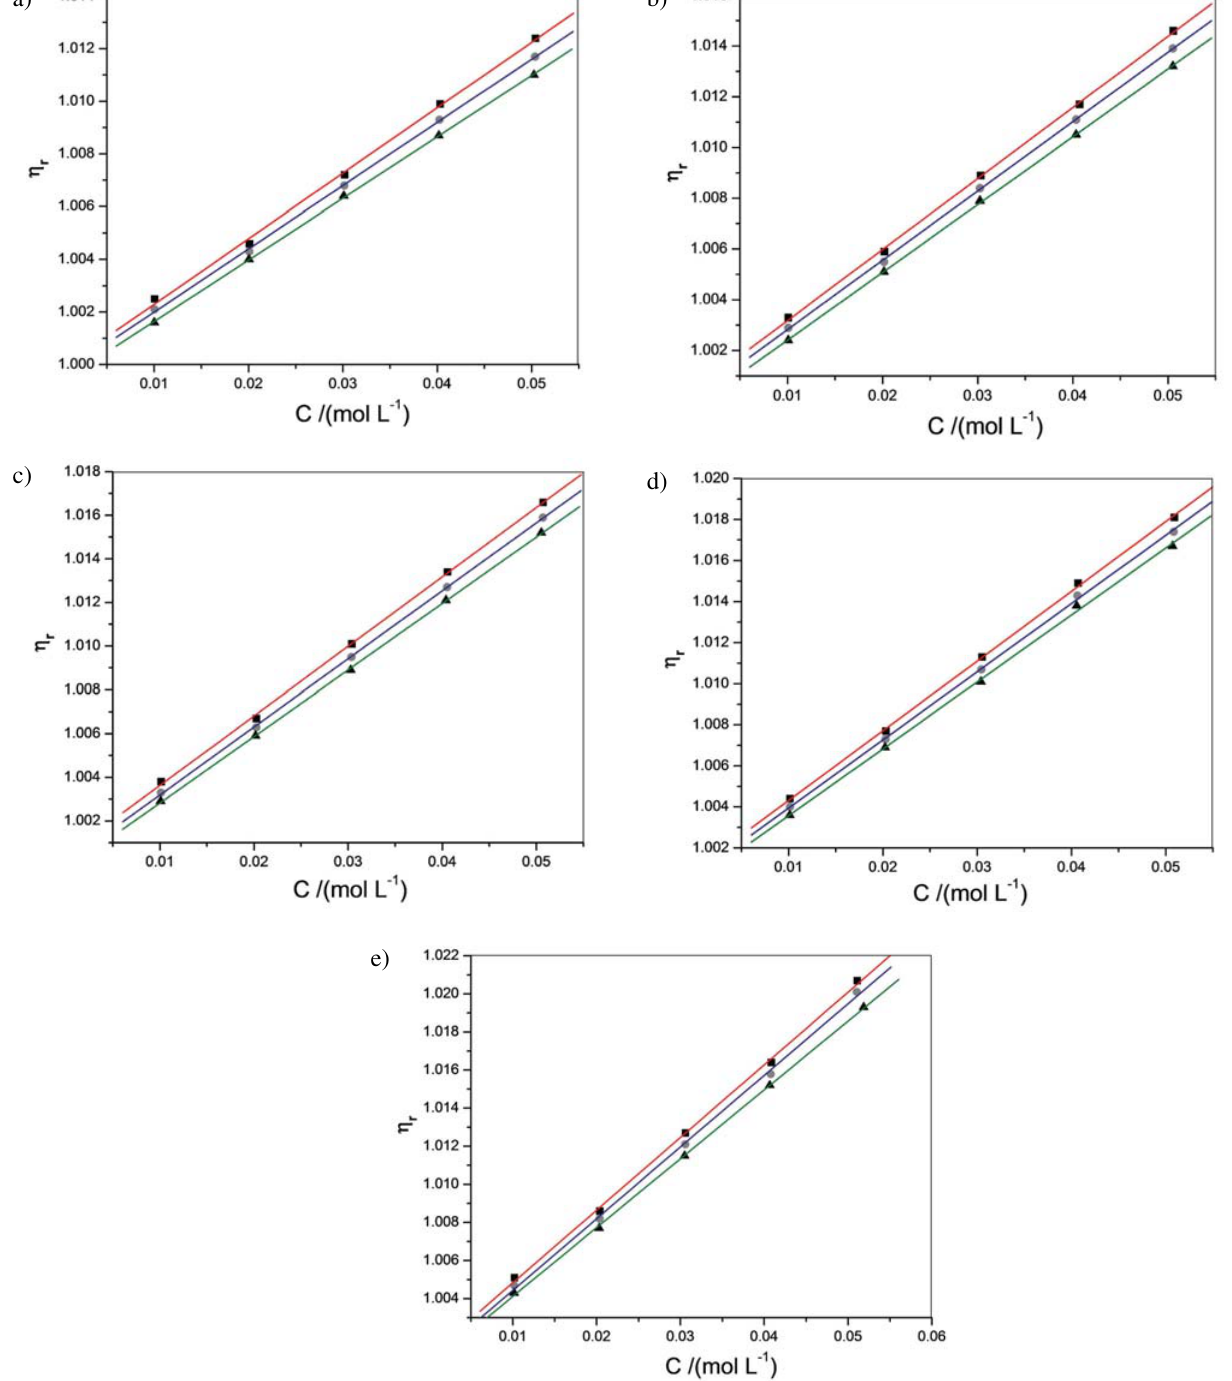
Figure 3. Variation of relative viscosity versus molarity of Asp in aqueous and aqueous + PD solutions: (a) water, (b) 5% PD, (c) 10% PD, (d) 15% PD and (e) 20% PD at temperatures, T/K = 298.15 ( (cid:2) ); 303.15 ( (cid:3) ); 308.15 ( (cid:2) Rani et al.: Interactions of L-Aspartic Acid with Aqueous Solution ...